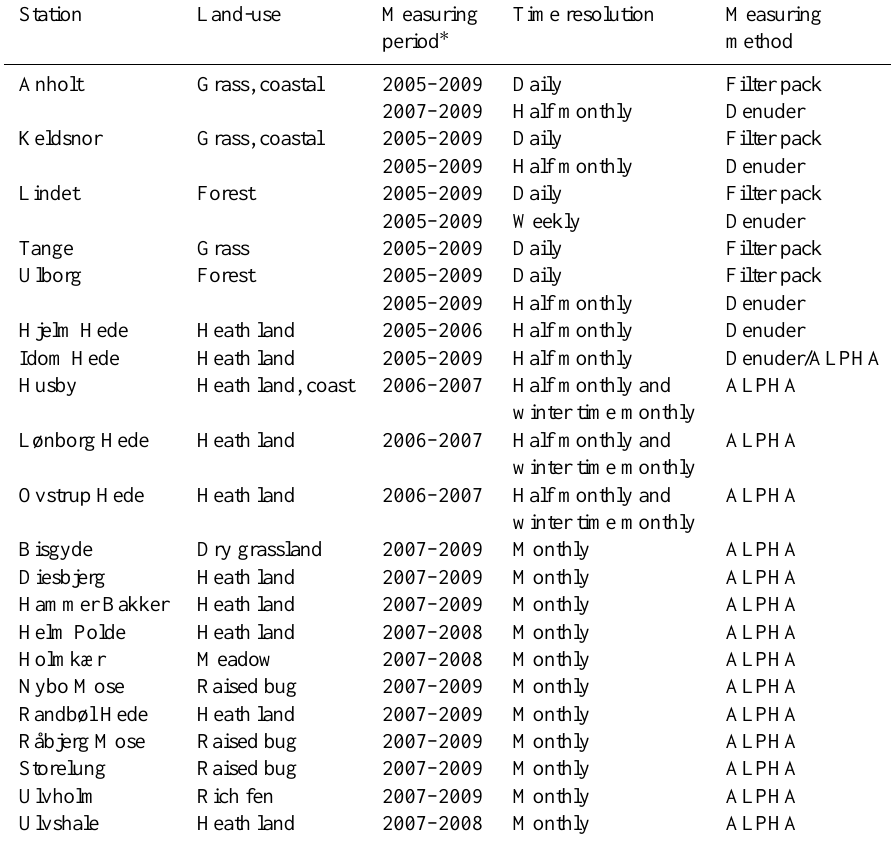
Table 1. Details about the monitoring sites applied in the current study: location, land-use, measuring period and time resolution and mea- suring method. The geographical positions are shown in Fig. 1a.